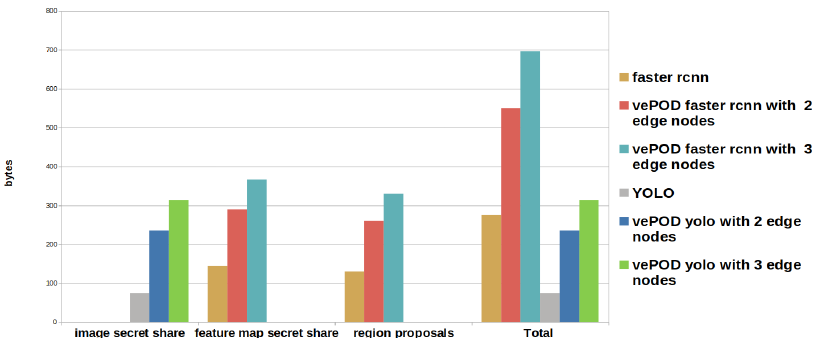
Figure 10. Comparison of storage and communication costs using vePOD Faster R-CNN and vePOD